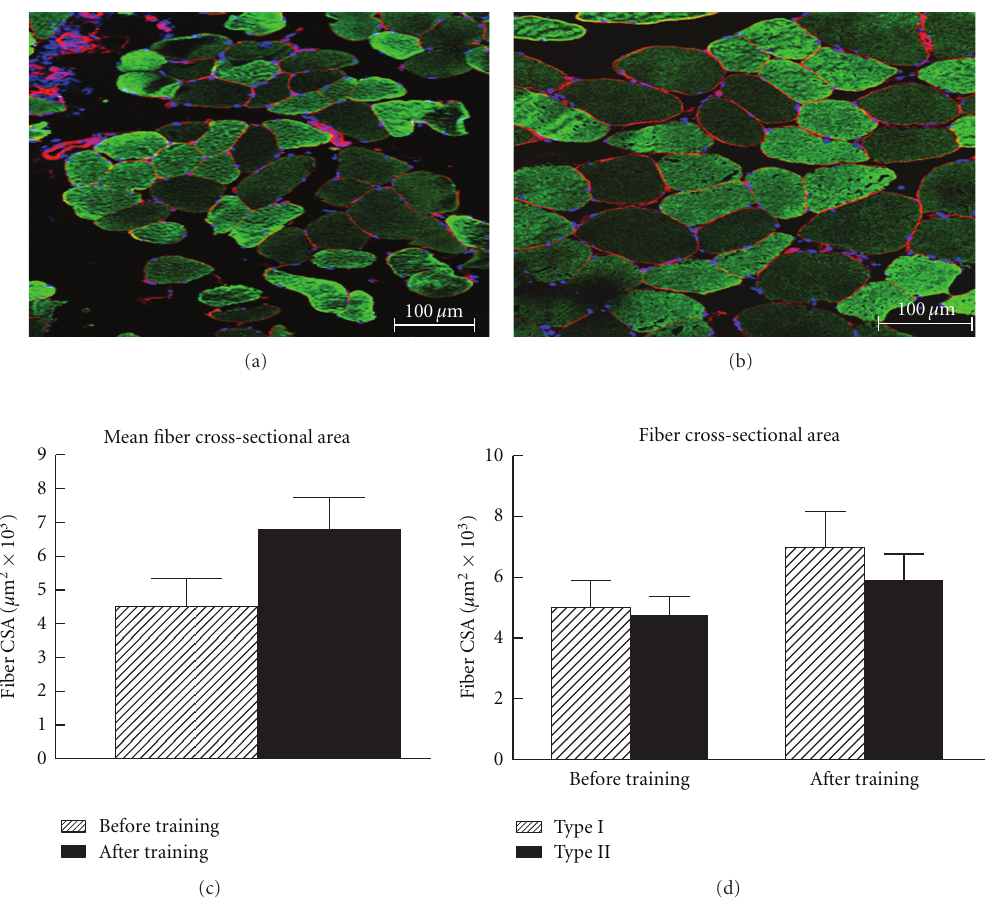
Figure 1: Frozen tissue cross sections incubated with anti-fast myosin heavy chain (F59). Fibers that were stained for FITC (green) were identified as type II fibers, and negatively stained fibers were identified as type I fibers. The basal lamina of each fiber was stained (red) with an anti-laminin antibody. (a) Type I and type II fibers from the vastus lateralis muscle obtained before exercise training. (b) Type I and type II fibers from the vastus lateralis muscle obtained after 16 weeks of strength training. (c) Quantification of the mean fiber area from the vastus lateralis. These data include both type I and type II fibers. The data were obtained before and after strength training. The data represent mean ± standard deviation of fiber area. (d) Type I and type II fiber areas of the vastus lateralis before and after strength training.